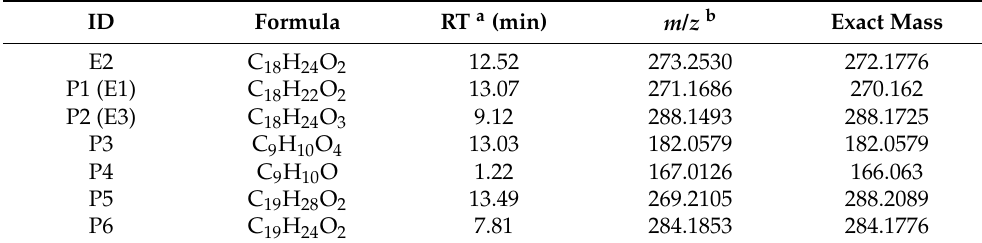
Table 1. LC-MS analysis of metabolites involved in E2 degradation by strain